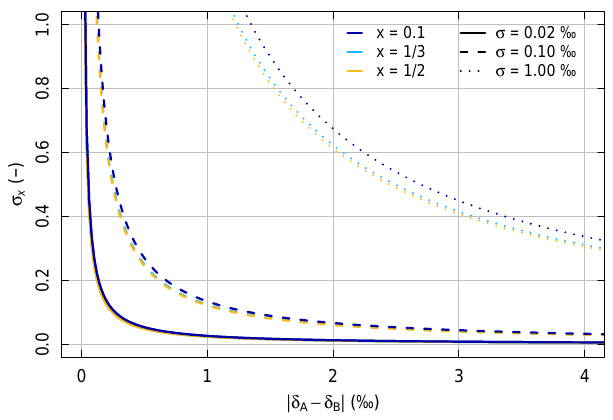
Figure 4. Standard error ( σ x ) associated with the estimation of the relative contribution ( x) of source A water to root water uptake in the case of two distinct sources (A and B of isotopic compositions δ A and δ B ) . Three x values (0.1, dark blue color; 1 / 3, light blue; 1 / 2, orange) and three values of standard errors associated with sampling and measurement of δ A , δ B , and of the isotopic compo- sition of the tiller sap water ( δ Ti ) (0.02, solid line; 0.10 and 1.00, dashed lines) are